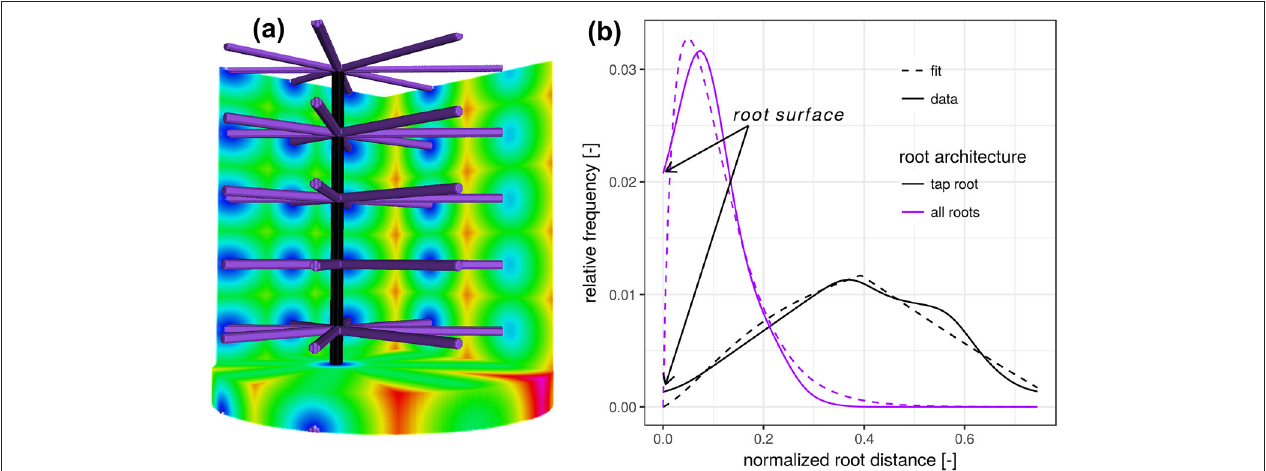
FIGURE 1 | (a) Synthetic test image of a vertical tap root only (black) and a fully developed root architecture including the tap root and lateral roots at various depths (purple). (b) The root distance histogram (RDH) of the single, vertical tap root follows a triangular distribution, whereas the addition of lateral roots changes the RDH toward a Gamma